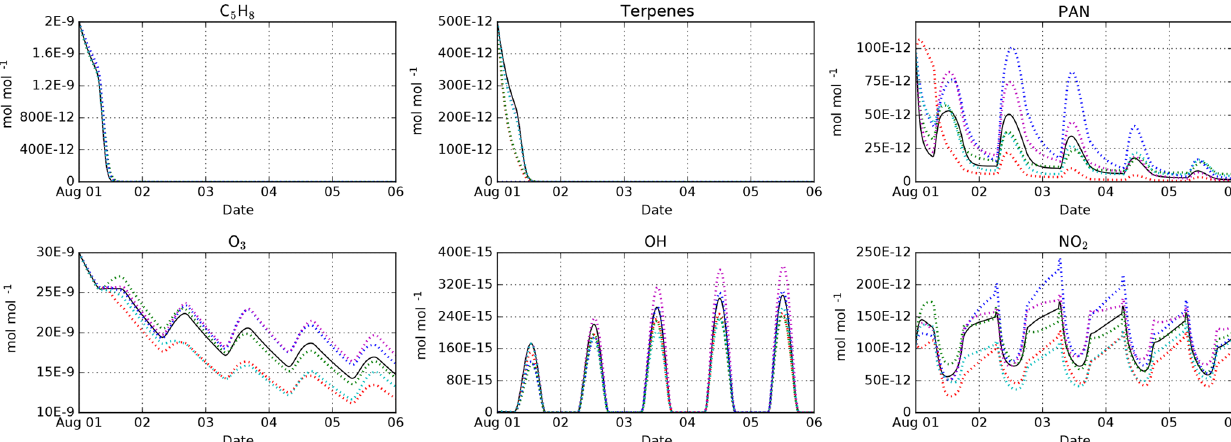
Figure 3. Intercomparison of the MOM (black), CB05BASCOE (red), MOZART (green), MIM1 (blue), MCM (magenta), and JAM002 (cyan) mechanisms. The simulations represent the boundary layer over the Amazon forest. They start on 1 August at midnight and last for 5 days. Temperature, pressure, and relative humidity are set to 301K, 101325Pa, and 70%, respectively. The model is initialized with 2nmolmol − 1 isoprene (C 5 H 8 ), 500pmolmol − 1 of terpenes (MOM: 100pmolmol − 1 of α -pinene, β -pinene, camphene, carene, and sabinene each; CB05BASCOE and MOZART: lumped terpenes; MIM1: no terpenes; MCM and JAM002: 200pmolmol − 1 α -pinene and 300pmolmol − 1 β -pinene), and 100pmolmol − 1 PAN. During the model simulation, emissions of NO are set to 3 . 3 × 10 − 9 cm − 2 s −